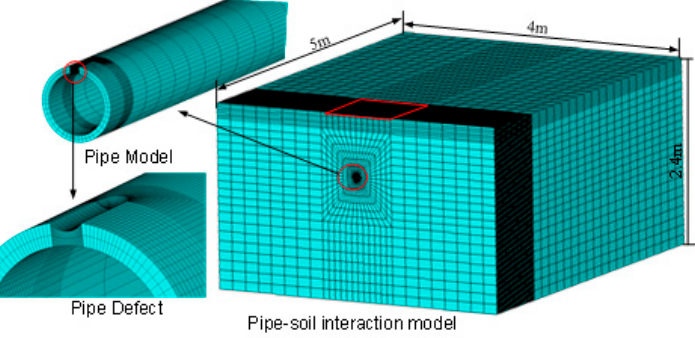
Figure 7. Finite element model of pipe-soil interaction.